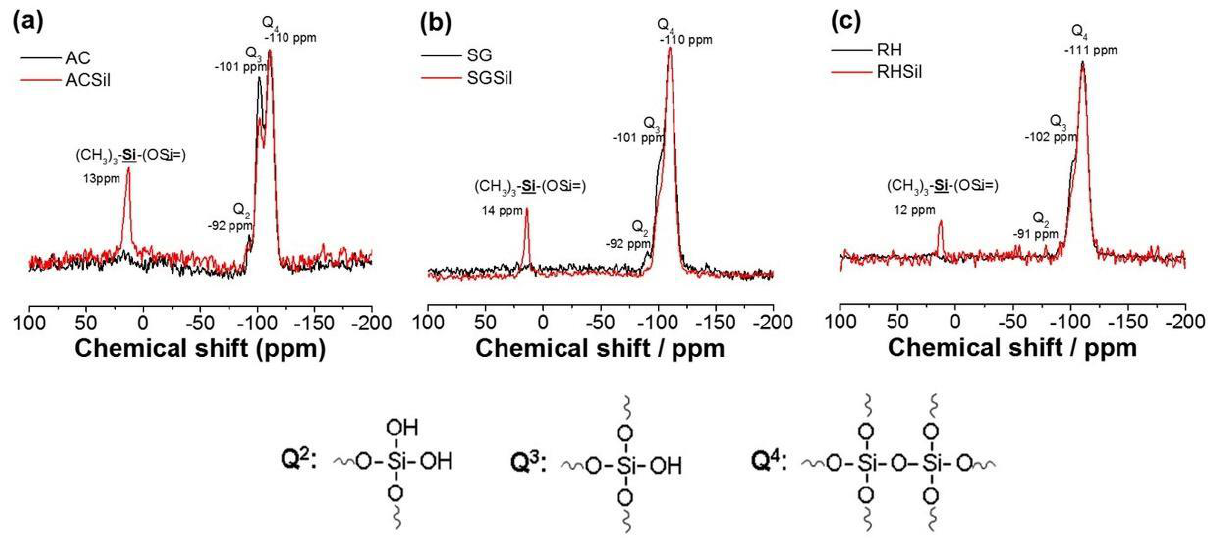
Figure 5. H 1 RMN for nanoparticles with unmodified and modified SiO 2 surfaces: ( a ) AC, ( b ) SG, and ( c )